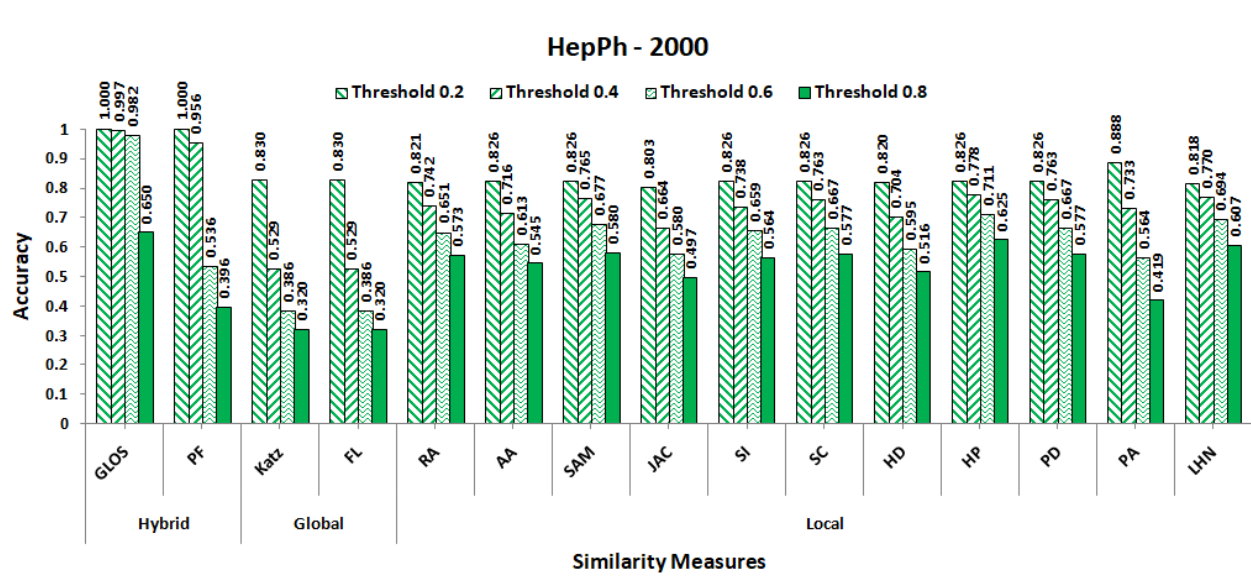
Figure 18. Comparisons of similarity measures on HepPh-2000 edge list from HepPh dataset Table 6. The table presents the results of accuracy on HepPh Dataset. Where, (T) represents the threshold, High represents the similarity measures obtaining highest accuracy, 2nd High corresponds to the similarity measures obtained second highest accuracy and low represents the similarity measures obtained lowest accuracy. The red color shows the Global approaches, the blue color shows the Local approaches and the green color shows the Hybrid approaches.